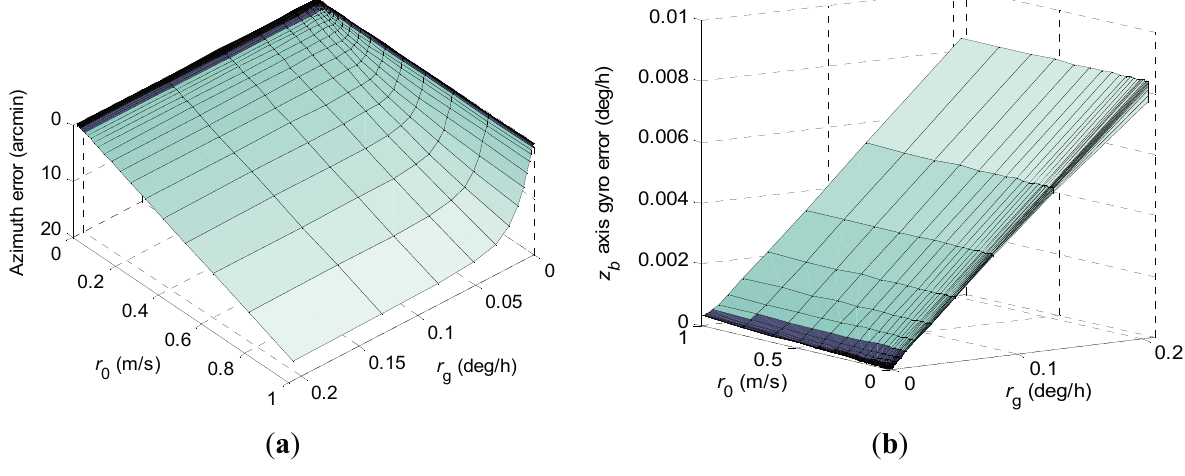
Figure 3. 1- σ values of final azimuth error and final z b axis gyro error at 600 s computed according to r 0 and r g when using the constrained KF scheme. ( a ) Azimuth error; ( b ) z b axis gyro